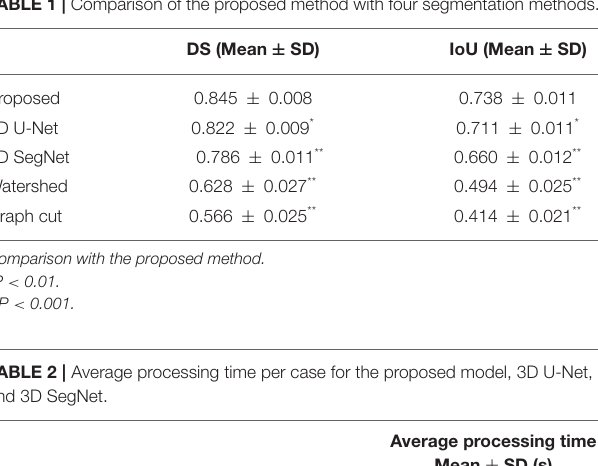
TABLE 1 | Comparison of the proposed method with four segmentation methods.